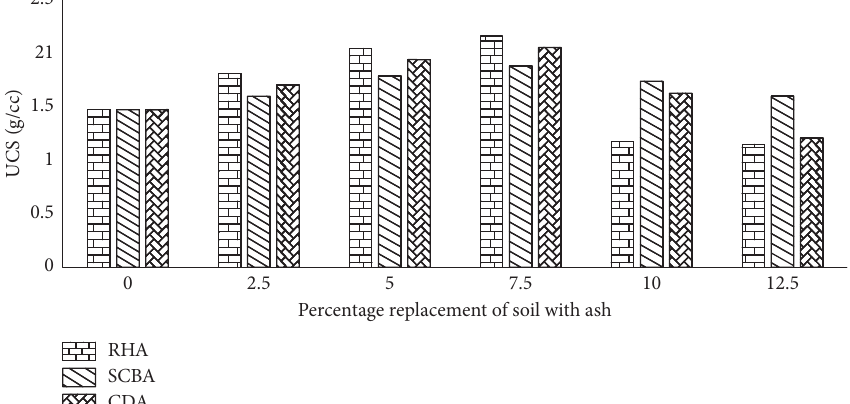
Figure 11: Stabilization of subgrade soil in India using indigenous nonplastic materials such as rice husk ash (RHA), sugarcane bagasse ash (SCBA), and cow dung ash (CDA). The in situ soil (depth of 1.5m–2.5m was intermediate plastic clay (figure taken from